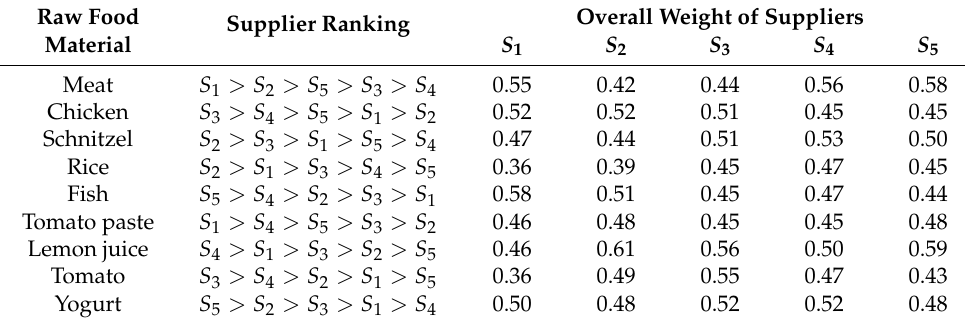
Table 4. Prioritization of suppliers.